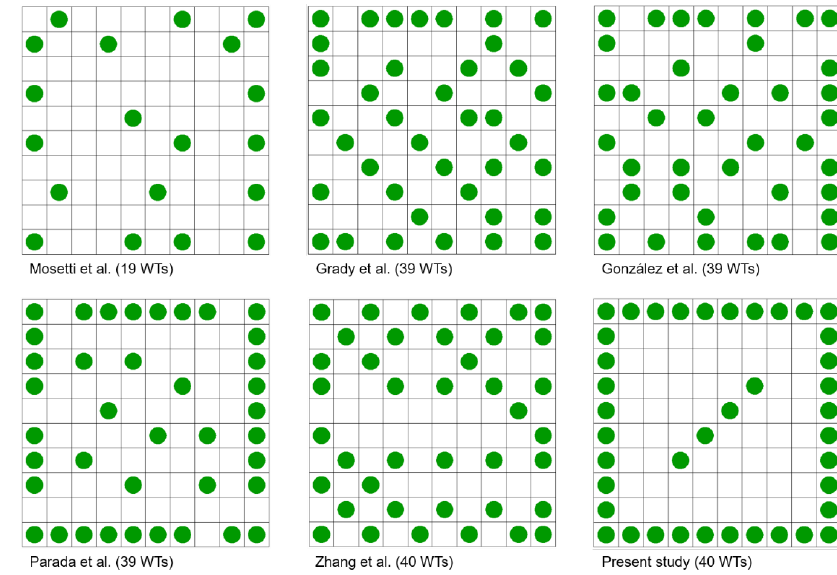
Figure 7. Layout results for case study (b). Table 4. Layout Results for Case Study (b).